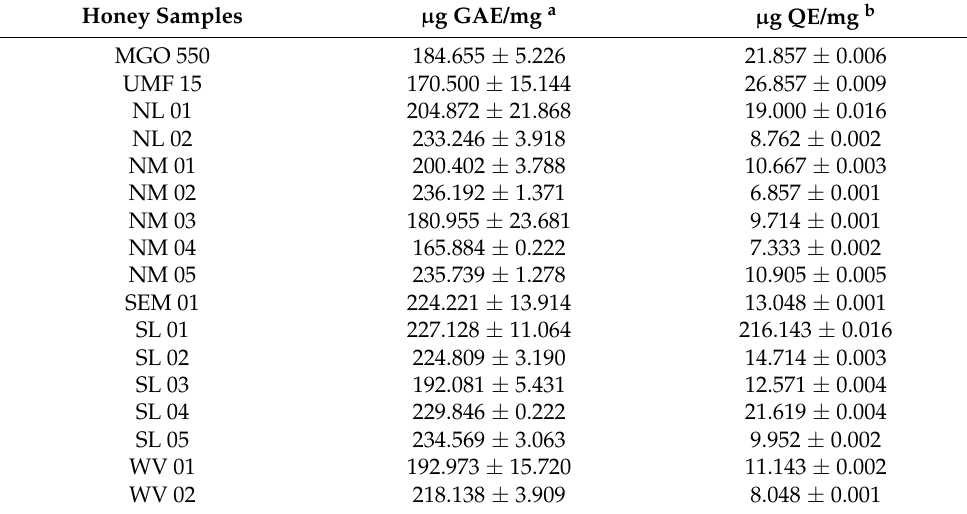
Table 3. Total Phenolic and Flavonoid Content of Honey Crude Extracts. Honey